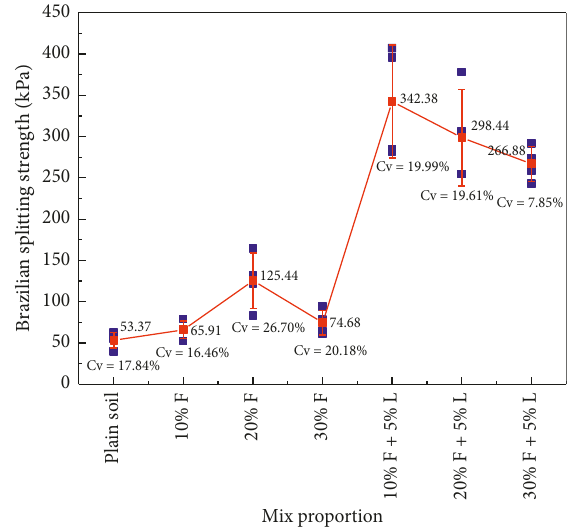
Figure 17: Brazilian splitting strength curve of stabilized soil (28